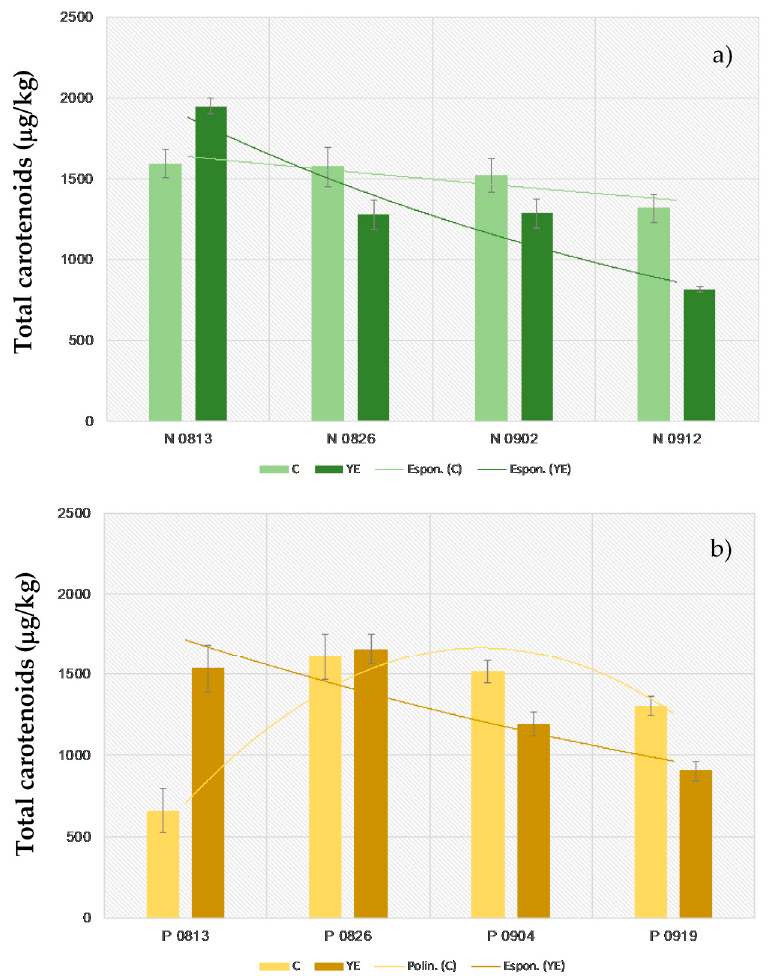
Figure 4. Total carotenoid variation in yeast extract-treated (YE) and control (C) Negro Amaro ( a ) and Primitivo ( b ) wine grapes during ripening.